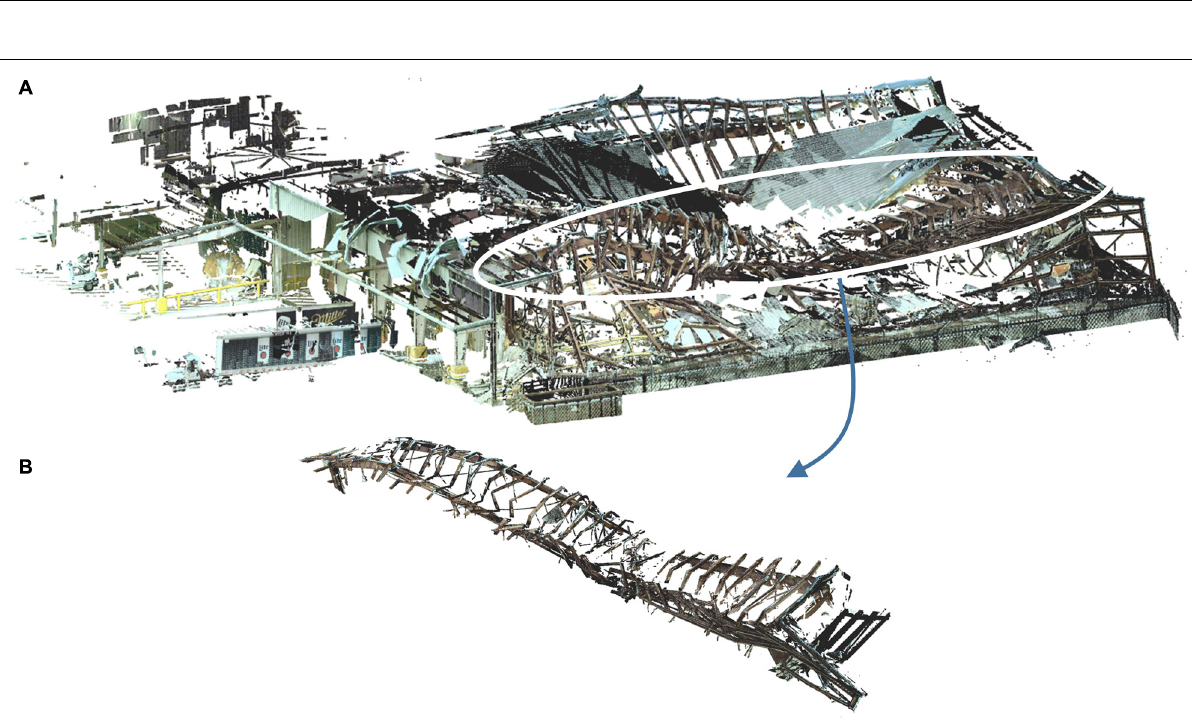
FIGURE 7 | 3D point cloud from lidar scans of the interior of the damaged marine storage building after cleaning (removal of debris to expose the structural system).